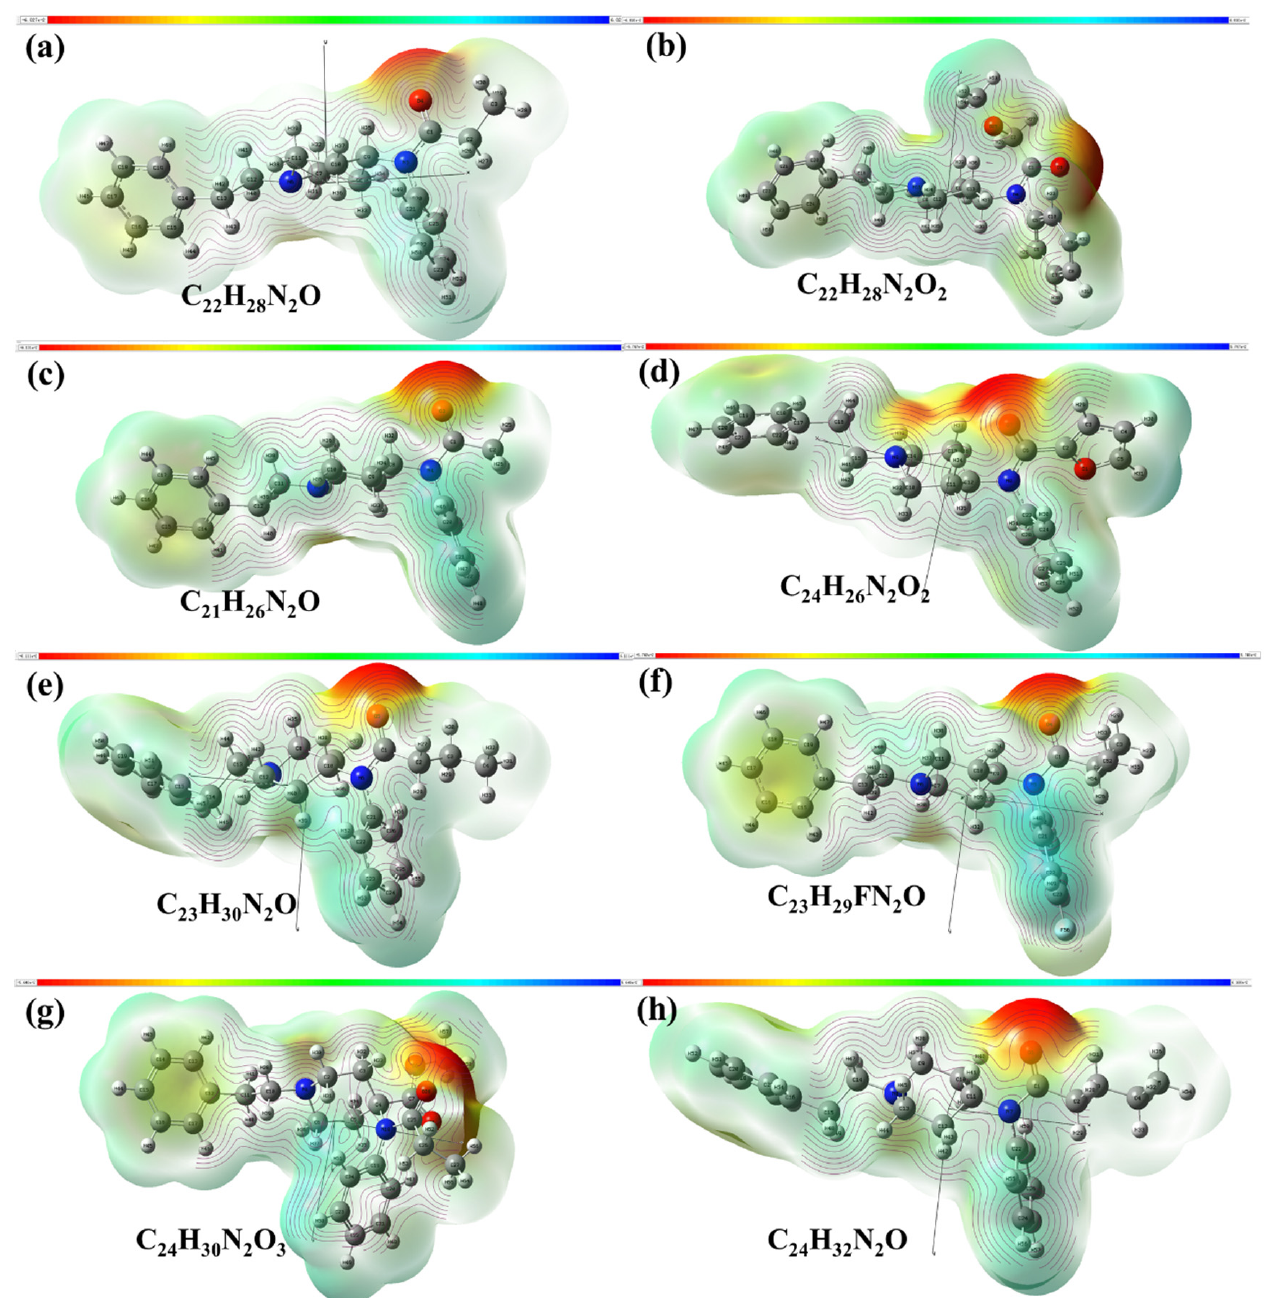
Figure 1. Geometric configuration of fentanyl molecules of ( a ) fentanyl, ( b ) methoxyacetylfentanyl, ( c ) acetylfentanyl, ( d ) furanylfentanyl, ( e ) butyrylfentanyl, ( f ) 4-fluoroisobutyrfentanyl, ( g ) carfentanil, and ( h ) valerylfentanyl.